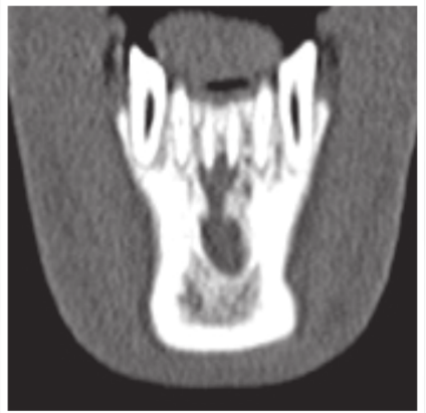
Figure 3: CT Image showing Dumbbell shape periapical lesion in relation to Mandibular central